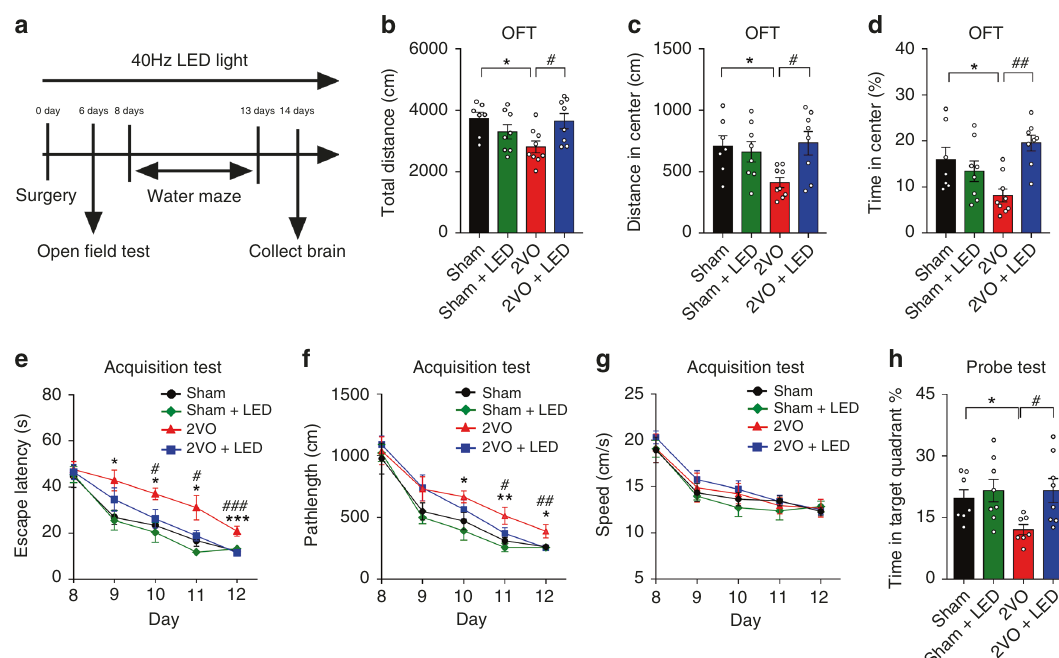
Fig. 3 Improvement of cognitive functions of 2VO mice after 40 Hz light visual stimulation. a A schema showing experimental design and timeline. b – d OFT results of four groups of mice. Total distance traveled ( b ), distance in the center ( c ), and percentage of time spent in the center ( d ) were measured and compared amongst the four experimental groups (Sham: n = 7; Sham + LED: n = 8; 2VO: n = 9; 2VO + LED: n = 8 in OFT). e Water maze test (WMM) was also performed on the four experimental groups with days indicated. Escape latency to the platform ( e ) was measured during the acquisition test at 8, 9, 10, 11, and 12 d after 2VO surgery. Pathlength ( f ) and locomotion speed ( g ) of the four groups were also recorded and plotted (Sham: n = 8; Sham + LED: n = 8; 2VO: n = 9; 2VO + LED: n = 10 in the acquisition test of MWM). h The percentage of time spent in the target quadrant during the spatial exploring stage of the MWM probe test (Sham: n = 7; Sham + LED: n = 8; 2VO: n = 7; 2VO + LED: n = 8 in the probe test of MWM). Data were mean ± SEM. Error bars indicated SEM. * indicates a statistical difference between Sham and 2VO group; # indicates a statistical difference between 2VO and 2VO + LED group. *, # P < 0.05, **, ## P < 0.01, ***, ### P < 0.001; Test used in b – d 2ANOVA with Tukey ’ s post hoc test; e – g RM-2ANOVA with LSD ’ s post hoc test;